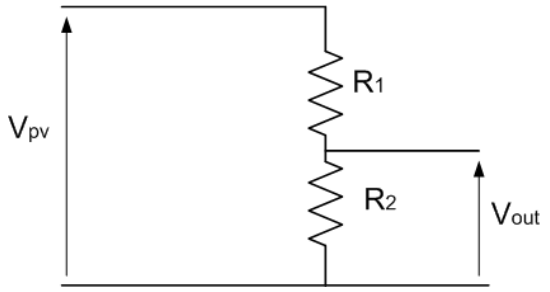
Figure 15. Divider voltage